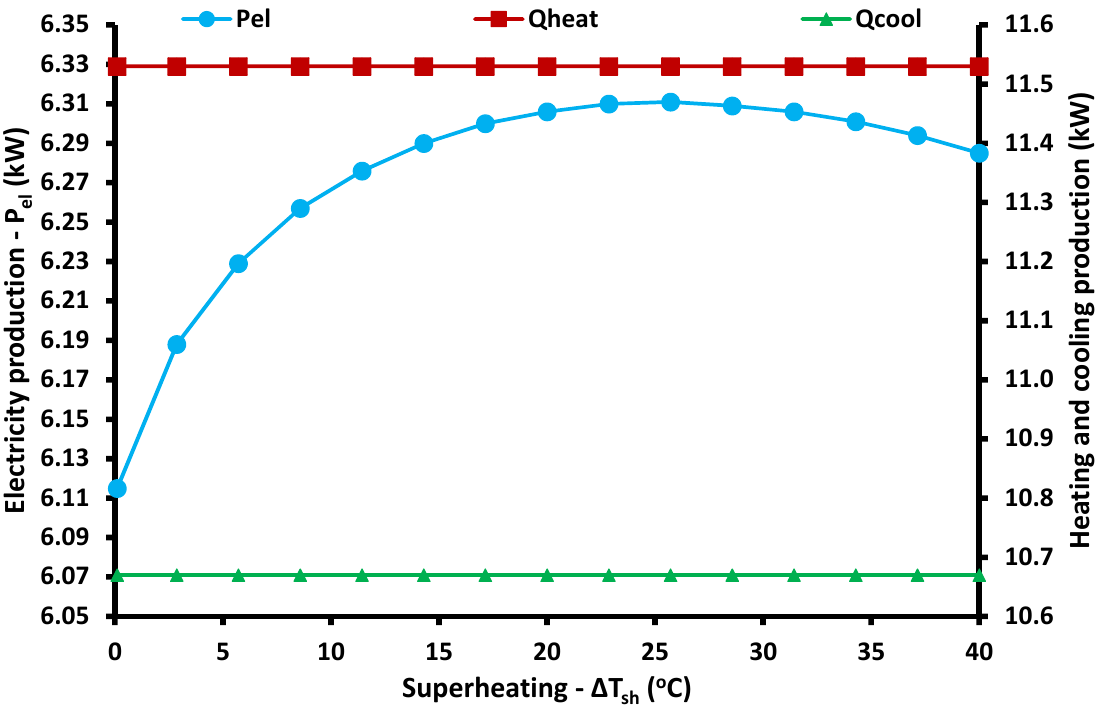
Figure 5. Electricity, heating, and cooling for different superheating levels.